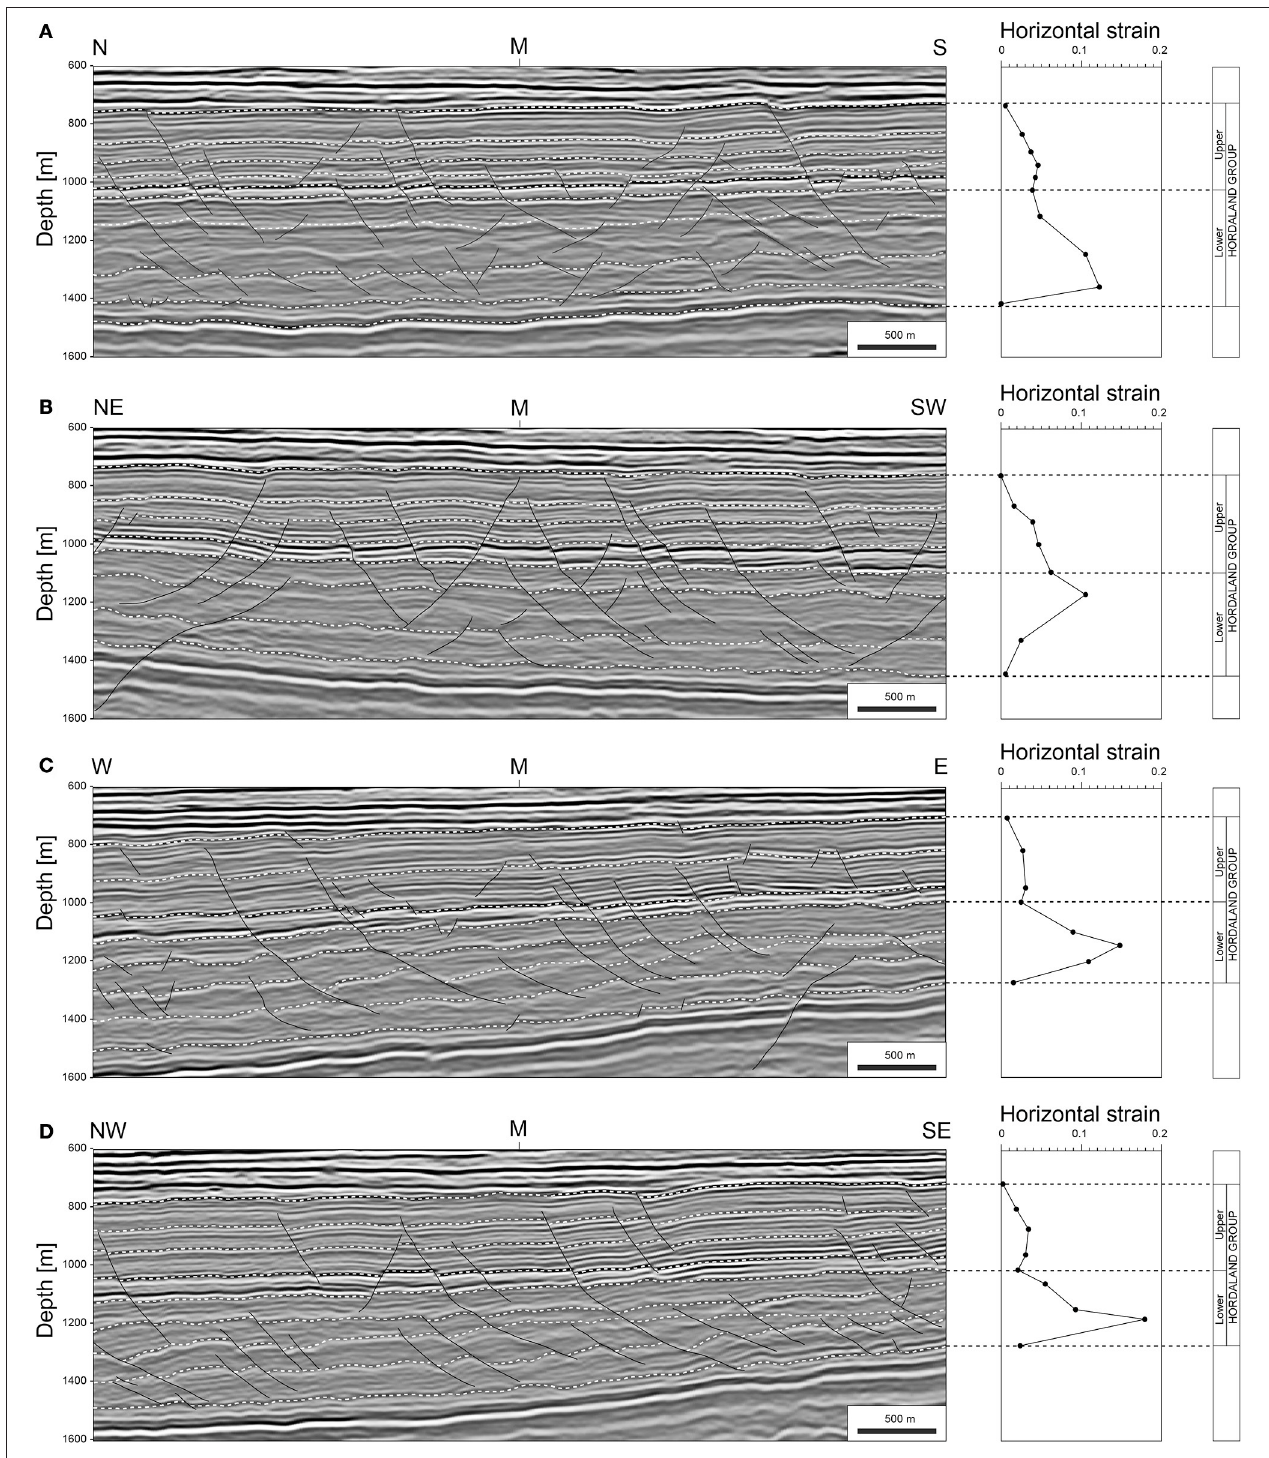
FIGURE 12 | Seismic sections with lateral strain discretized onto polygonal faults. Strain was extracted from seismic sections in four directions (A–D). Note that the bulk strain has been accumulated in the lower Hordaland Group. See Figure 2b for location of sections.